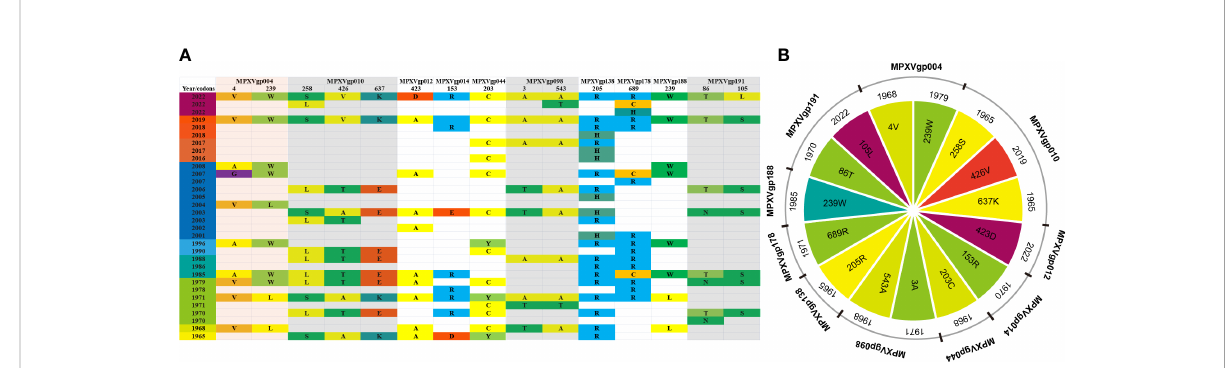
FIGURE 5 Amino acid substitution pro fi les of the 10 positive selection genes in a time scale. (A) The amino acid sequences at the 10 MPXV genes ’ positive selection sites evolved over time. The genes that encode proteins with more than one positive selection sites are highlight with a light color. (B) The earliest year when the positive amino acid substitutions